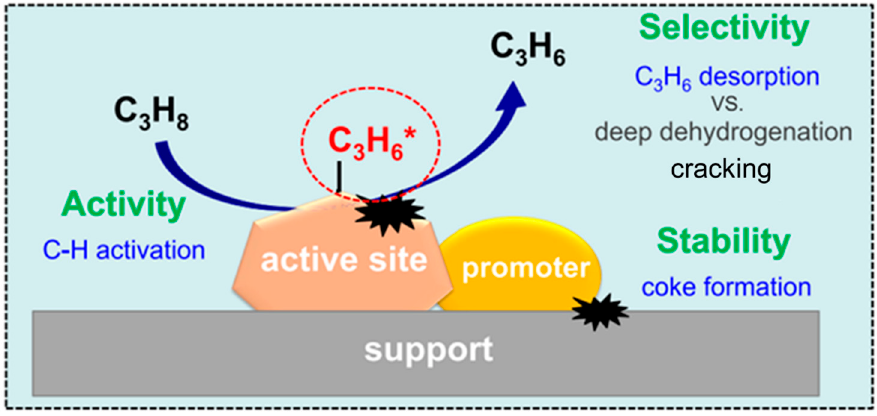
Figure 1. Schematic illustration of different steps during PDH reactions. Reprinted and modified with permission from ref. [2]. Copyright 2020 American Chemical Society.